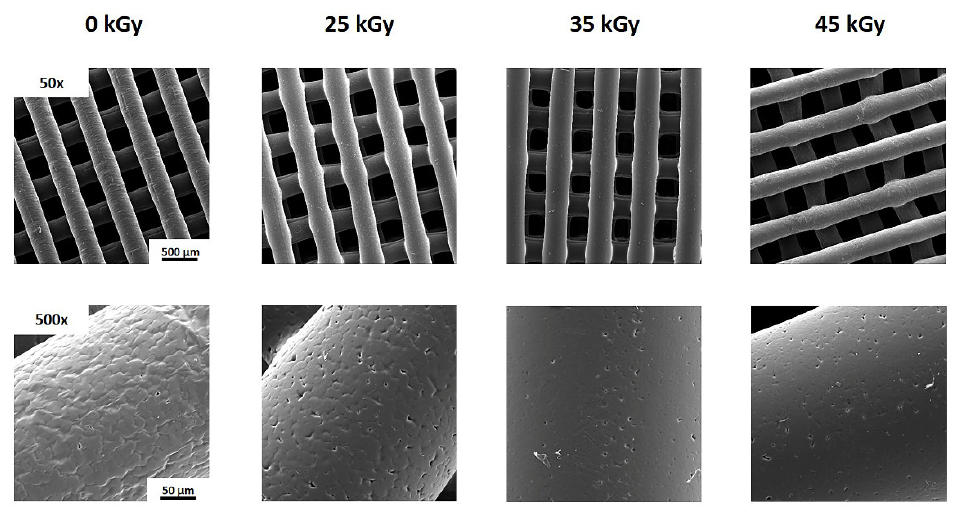
Figure 2. SEM images of gamma sterilized and unsterilized PCL scaffolds.